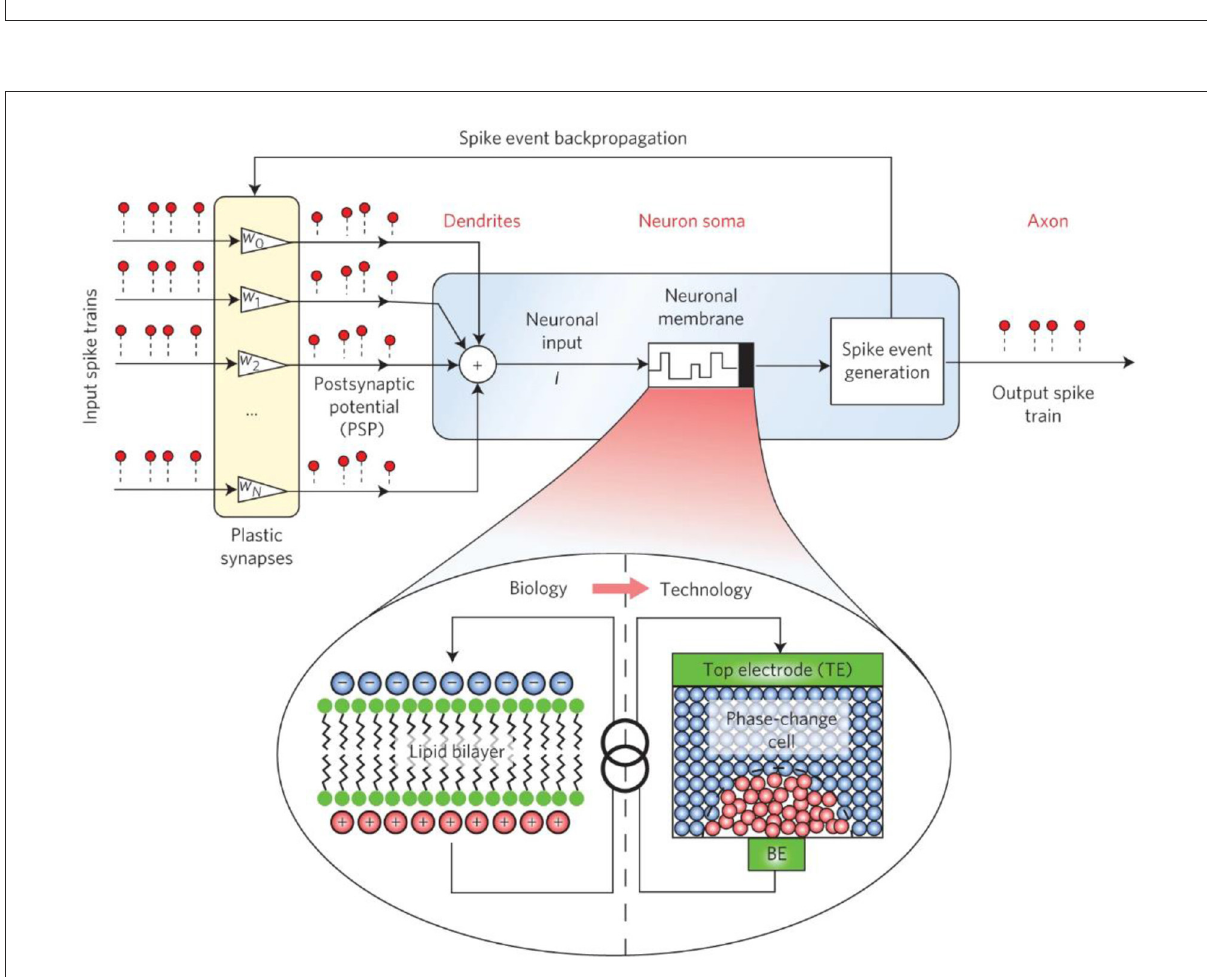
FIGURE10 Basic structure diagram of IBM phase-change neuron (Tuma et al.,